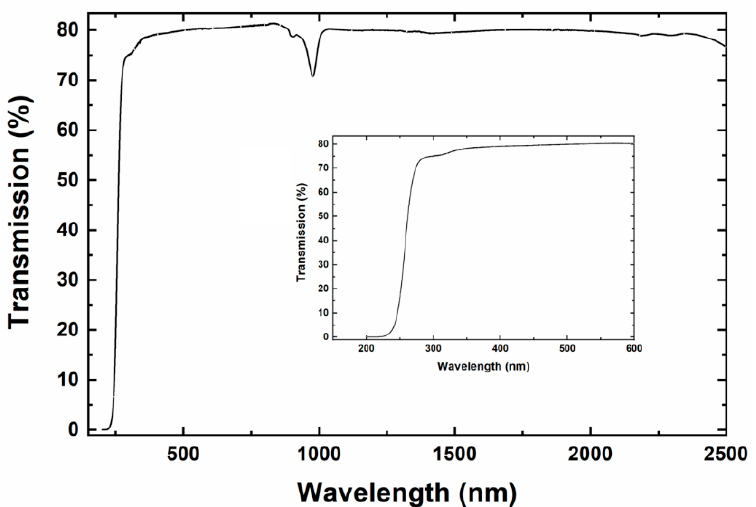
Figure 20. Transmission spectrum of LYSB:Yb (4 at.%) crystal. The inset figure presents the trans- mission over UV and VIS wavelength ranges. Reprinted with permission from ref. [44], copyright 2020, Elsevier.